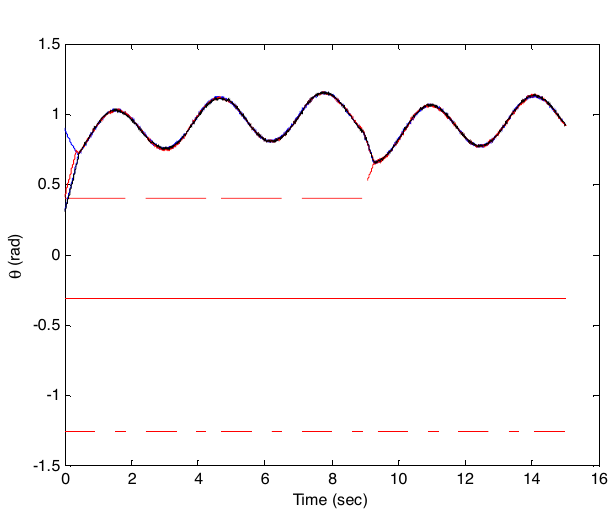
Figure 12. Consensus control on variable velocity of seven agents with attacks.